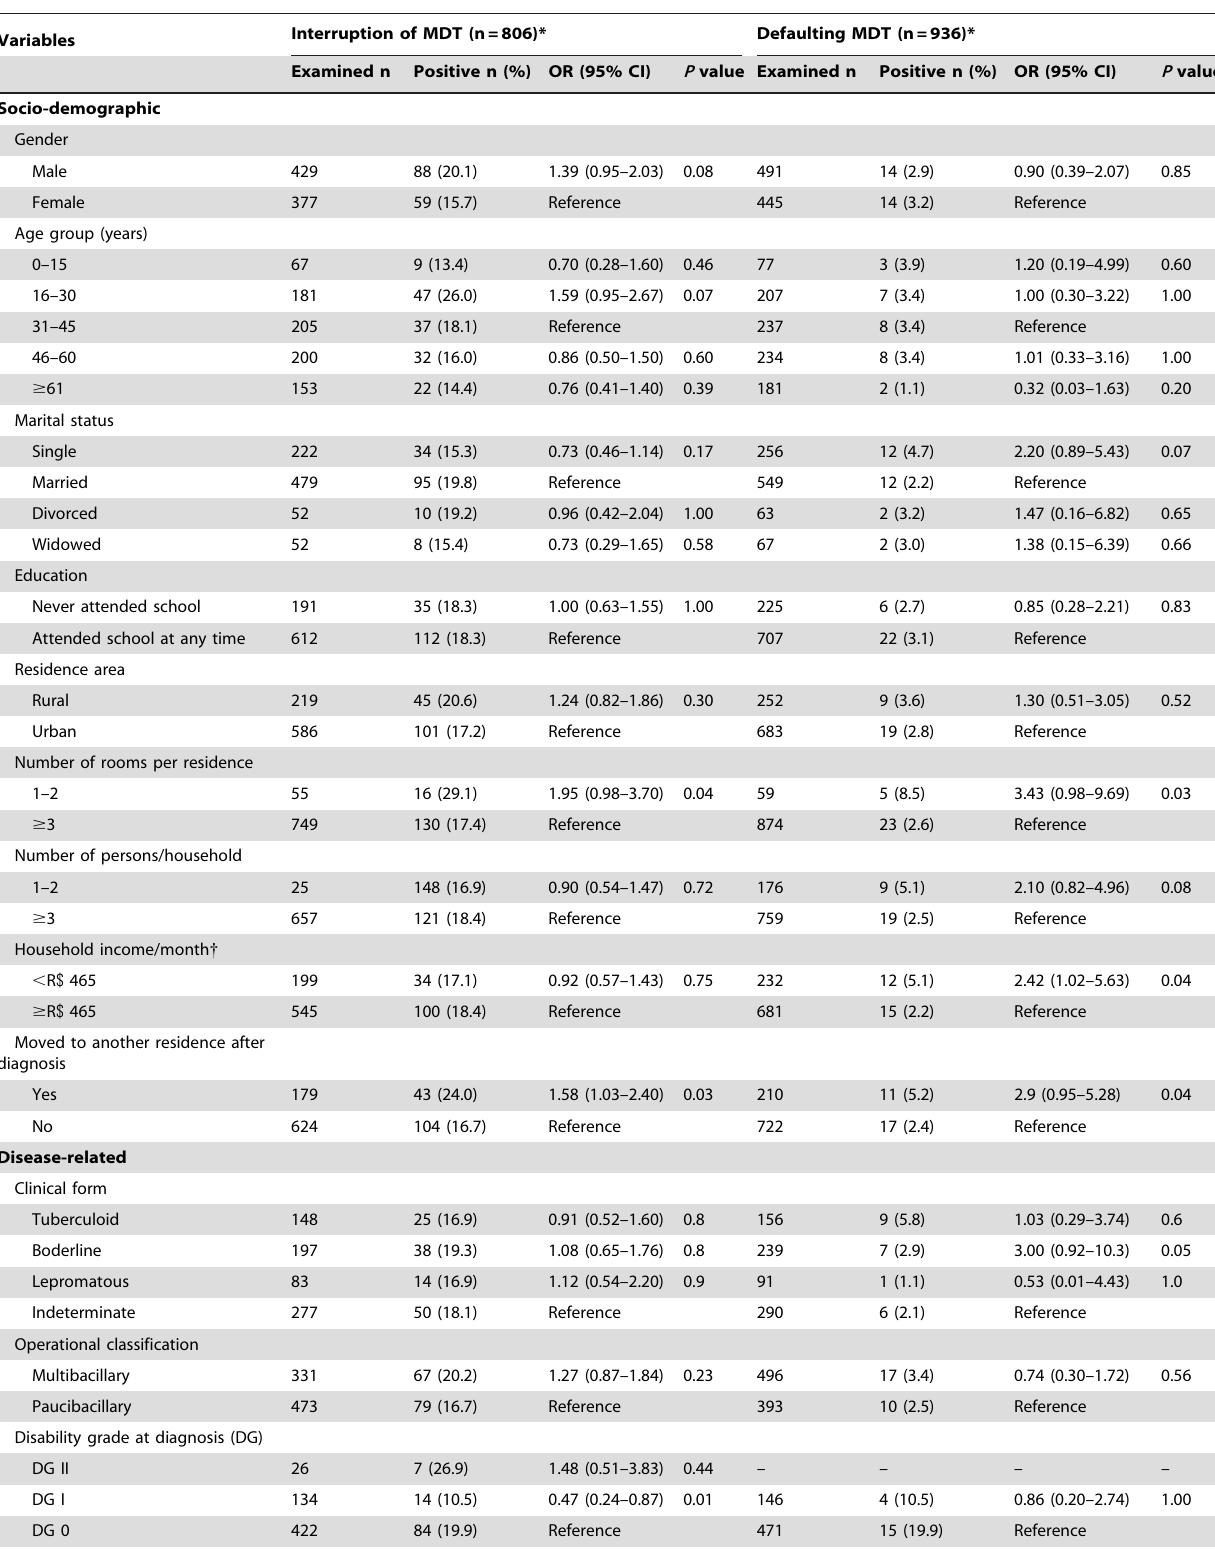
Table 1. Bivariate analysis of factors associated with interruption of, and defaulting multidrug therapy against leprosy.